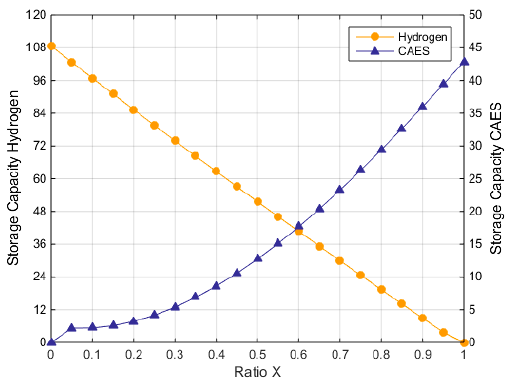
Figure 10. Storage capacities of H 2 and CAES with respect to X . Calculated based on profiles shown in Figure 8.